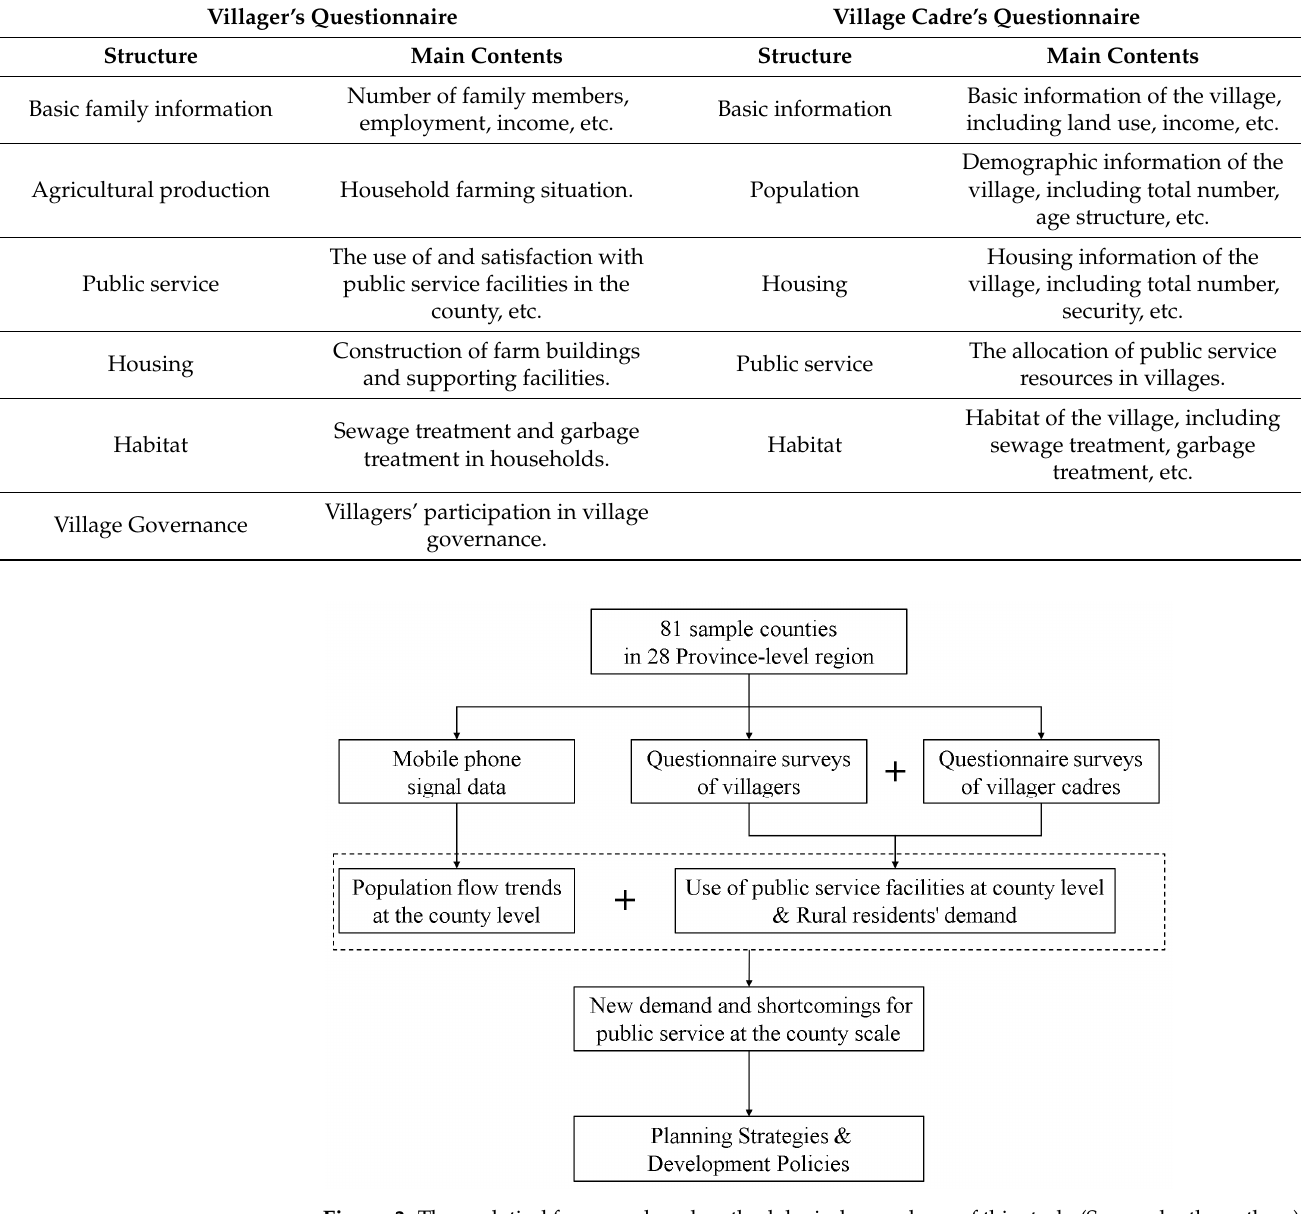
Figure 3. The analytical framework and methodological procedures of this study (Source: by the authors).